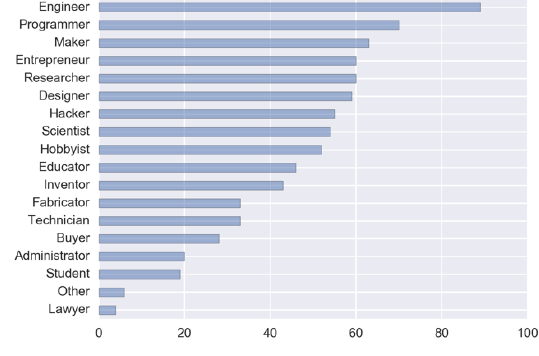
Fig. 1 : Reported roles in the OH